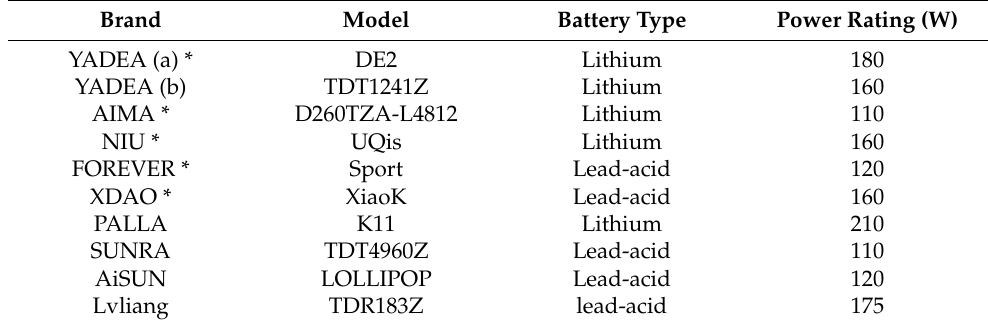
Table 1. E-bikes used in preliminary study (marked with *) and evaluation.